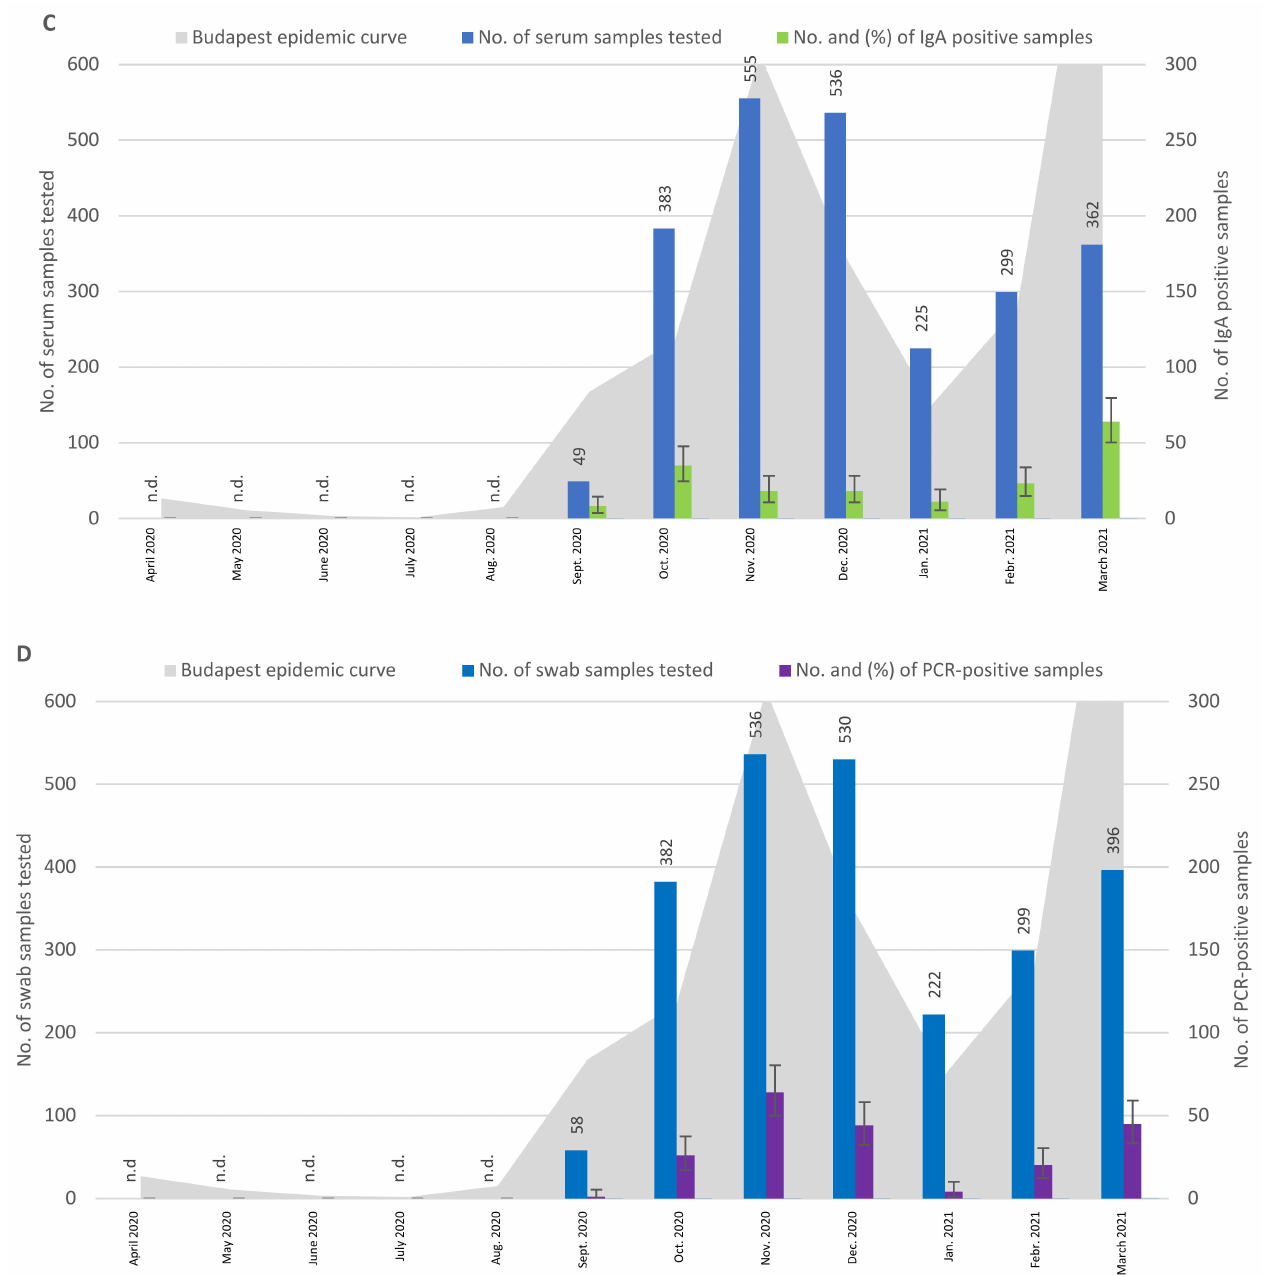
Figure 1. Monthly distribution and results of samples from participants with no known COVID-19 contacts. Participants are investigated for IgG and IgA antibodies using ELISA, for symptoms using a questionnaire, and for the presence of SARS-CoV-2 RNA in nasopharyngeal swab samples using RT- PCR. ( A ) Monthly distribution of participants with COVID-19 symptoms. ( B ) Monthly distribution of serum samples tested for IgG results. ( C ) Monthly distribution of serum samples tested for IgA results. ( D ) Monthly distribution of swab samples and PCR results. “n.d.”—not